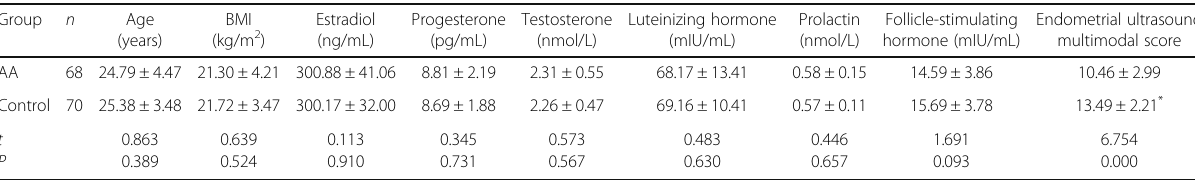
Table 2 Different parameters in two groups Group n